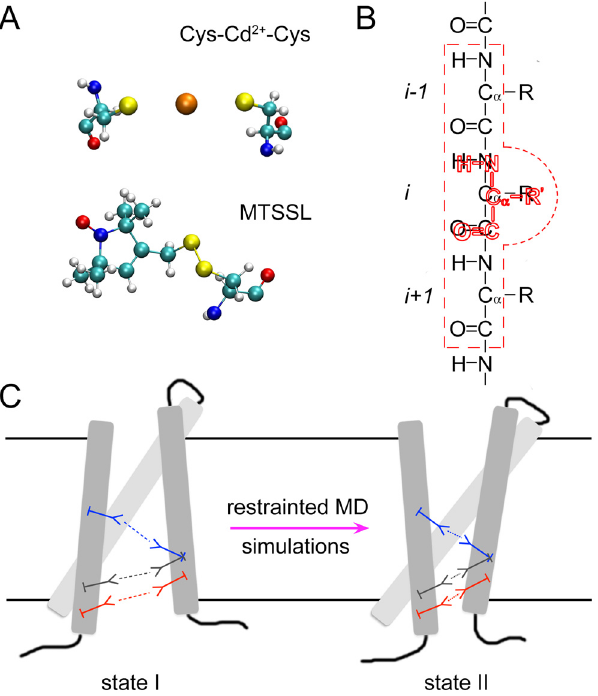
Fig 1. Schematic of the molecular fragments method. (A) Each structural constraint (e.g., a metal ion bridge or a spin-label) is present as a molecular fragment with all atomic details in the system. (B) The residue (s) in the molecular fragment (colored in red) is/are attached to the targeting residue(s) in the wild-type protein, via harmonic restraints, with their backbone atoms (N, C, O and C α ) staying on top of each other, respectively. The residue in the molecular fragment does not have interactions with its targeting residue in the wild-type protein (residue i ), and the interactions between the backbone atoms of the residue in the molecular fragment and the backbone atoms of the two nearby residues in the wild-type protein (residues i -1 and i +1; embraced by red dashed lines) are also turned off. (C) During the restrained MD simulations, the interactions within each molecular fragment are evaluated accurately triggering the conformational changes of the wild- type protein, while different molecular fragments do not have interactions with one another.